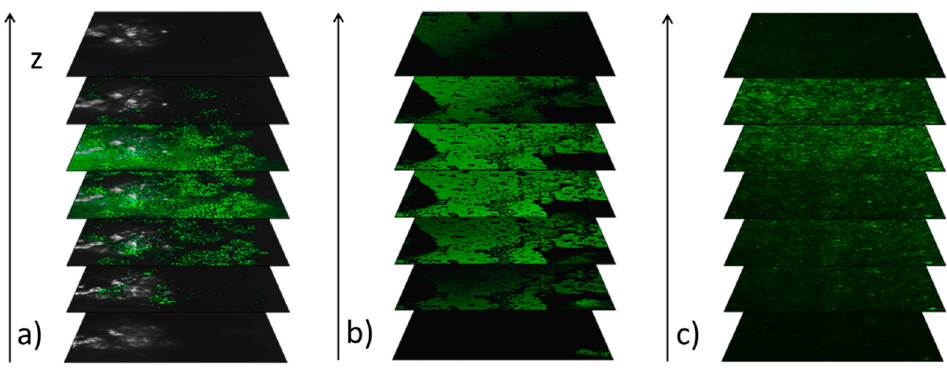
Figure 4. The qualitative representation of the fluorescence intensity in the subsequent slices of Sample 1 ( a ), oleic acid ( b ) and Composite 6 ( c ). The z axis is perpendicular to the x–y plane (parallel to the surface of the microscope slide).